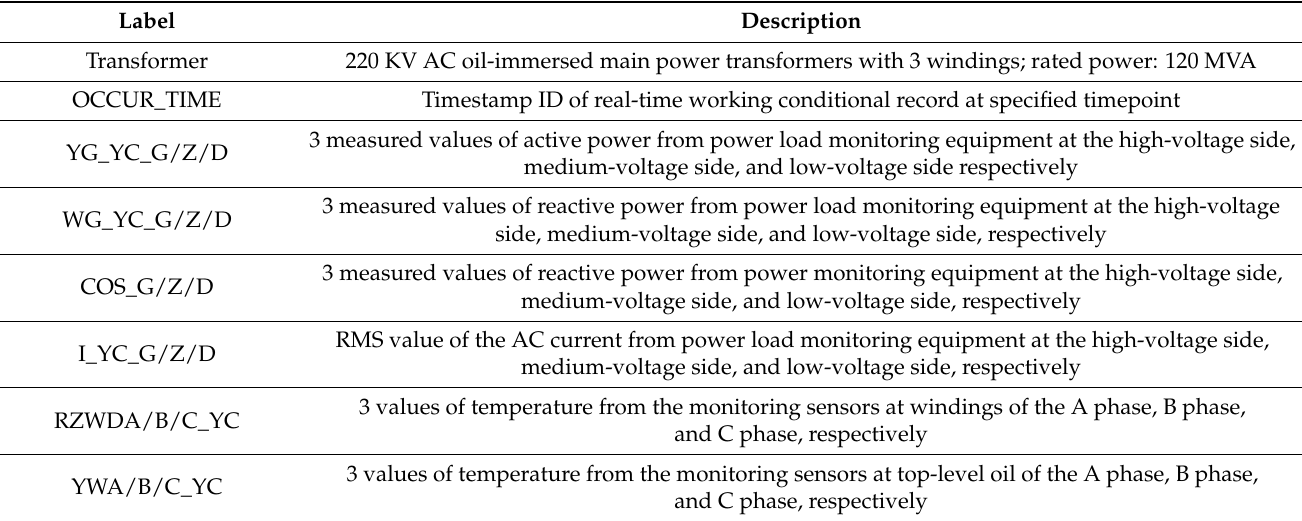
Table 1. Description of the transformer’s